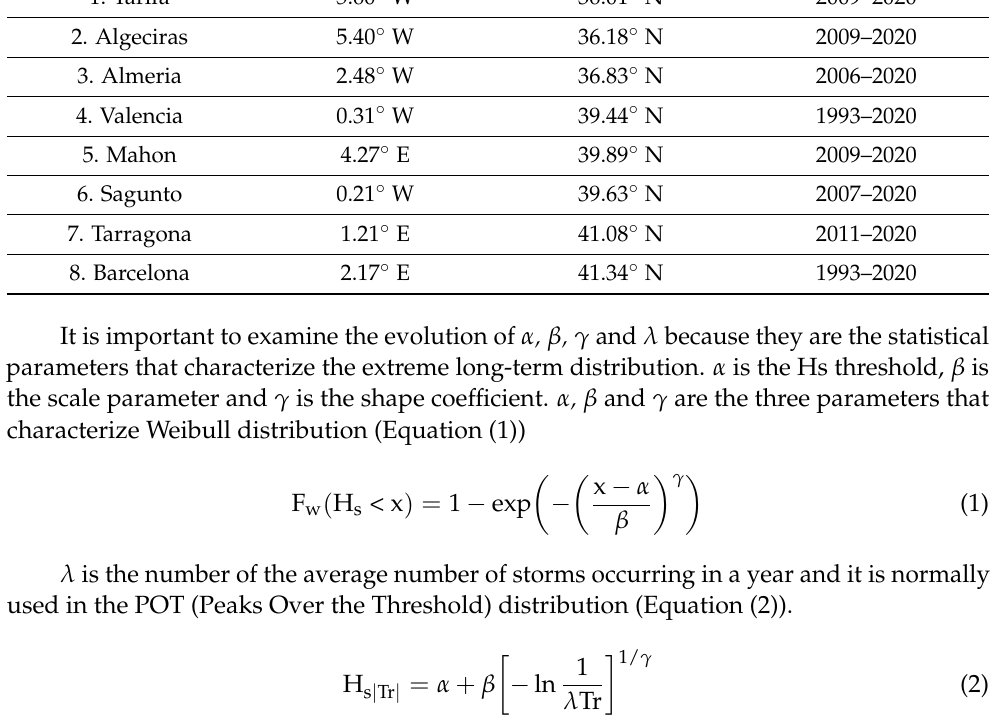
Table 2. List of tide gauges used in the study. Tide Gauge Longitude Latitude